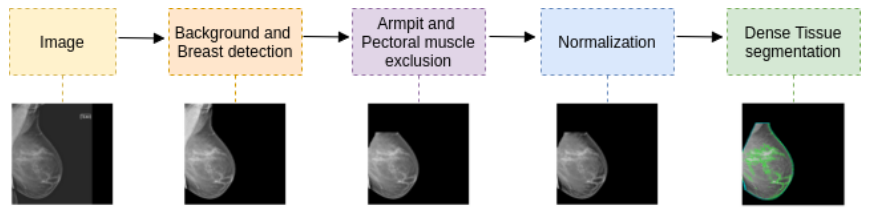
Figure 1. Segmentation pipeline. The last step is the deep-learning-based model for dense-tissue segmentation, which is the focus of the present